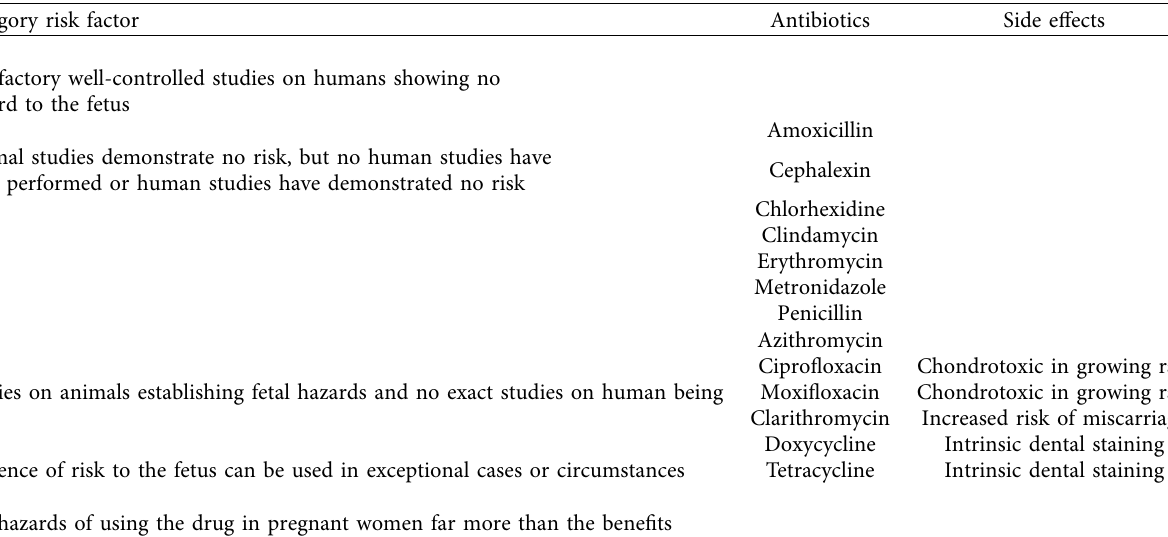
Table 4: FDA risk classes of antibiotics used during